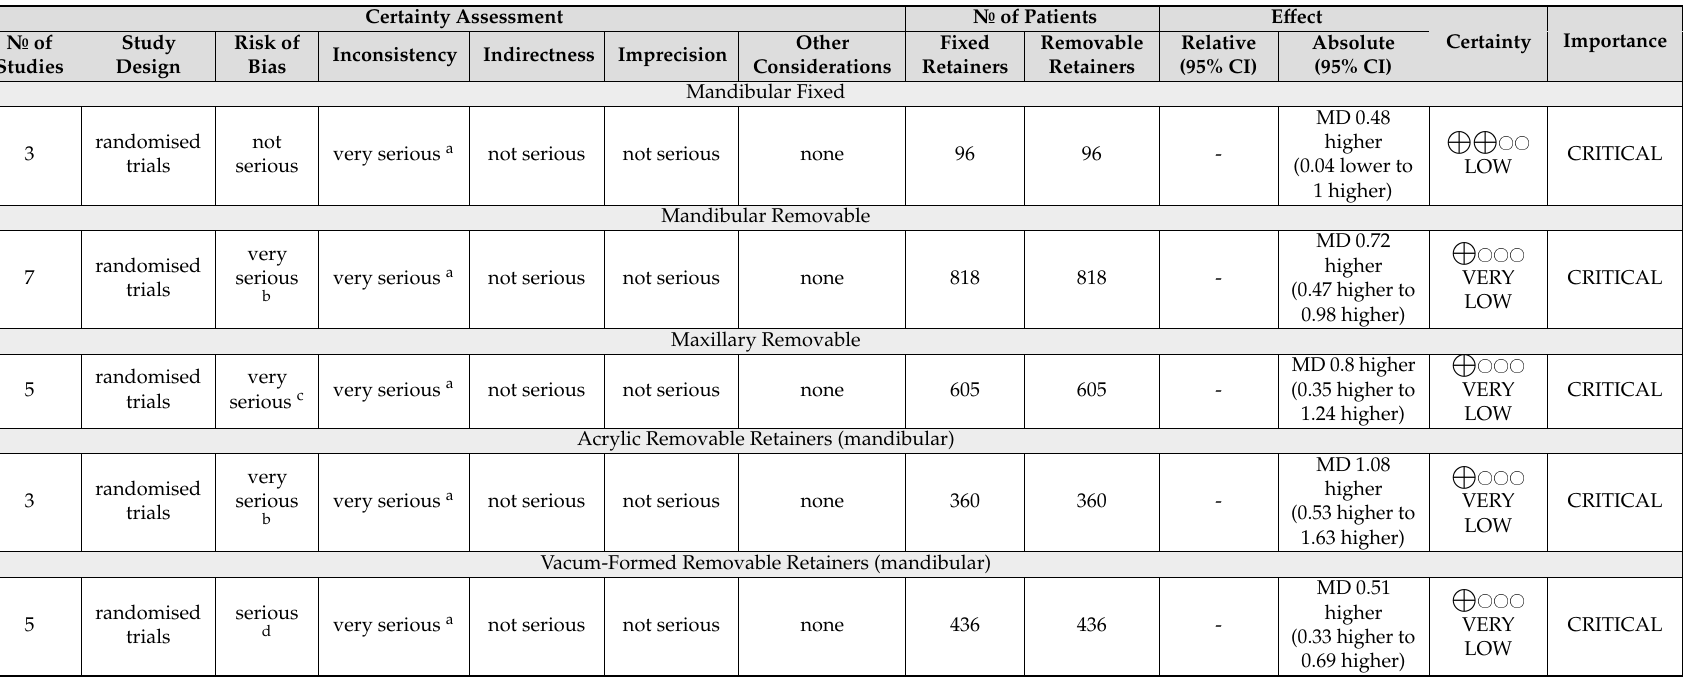
Table 5. Should fixed retainers or removable retainers be used for maintaining the alignment of anterior